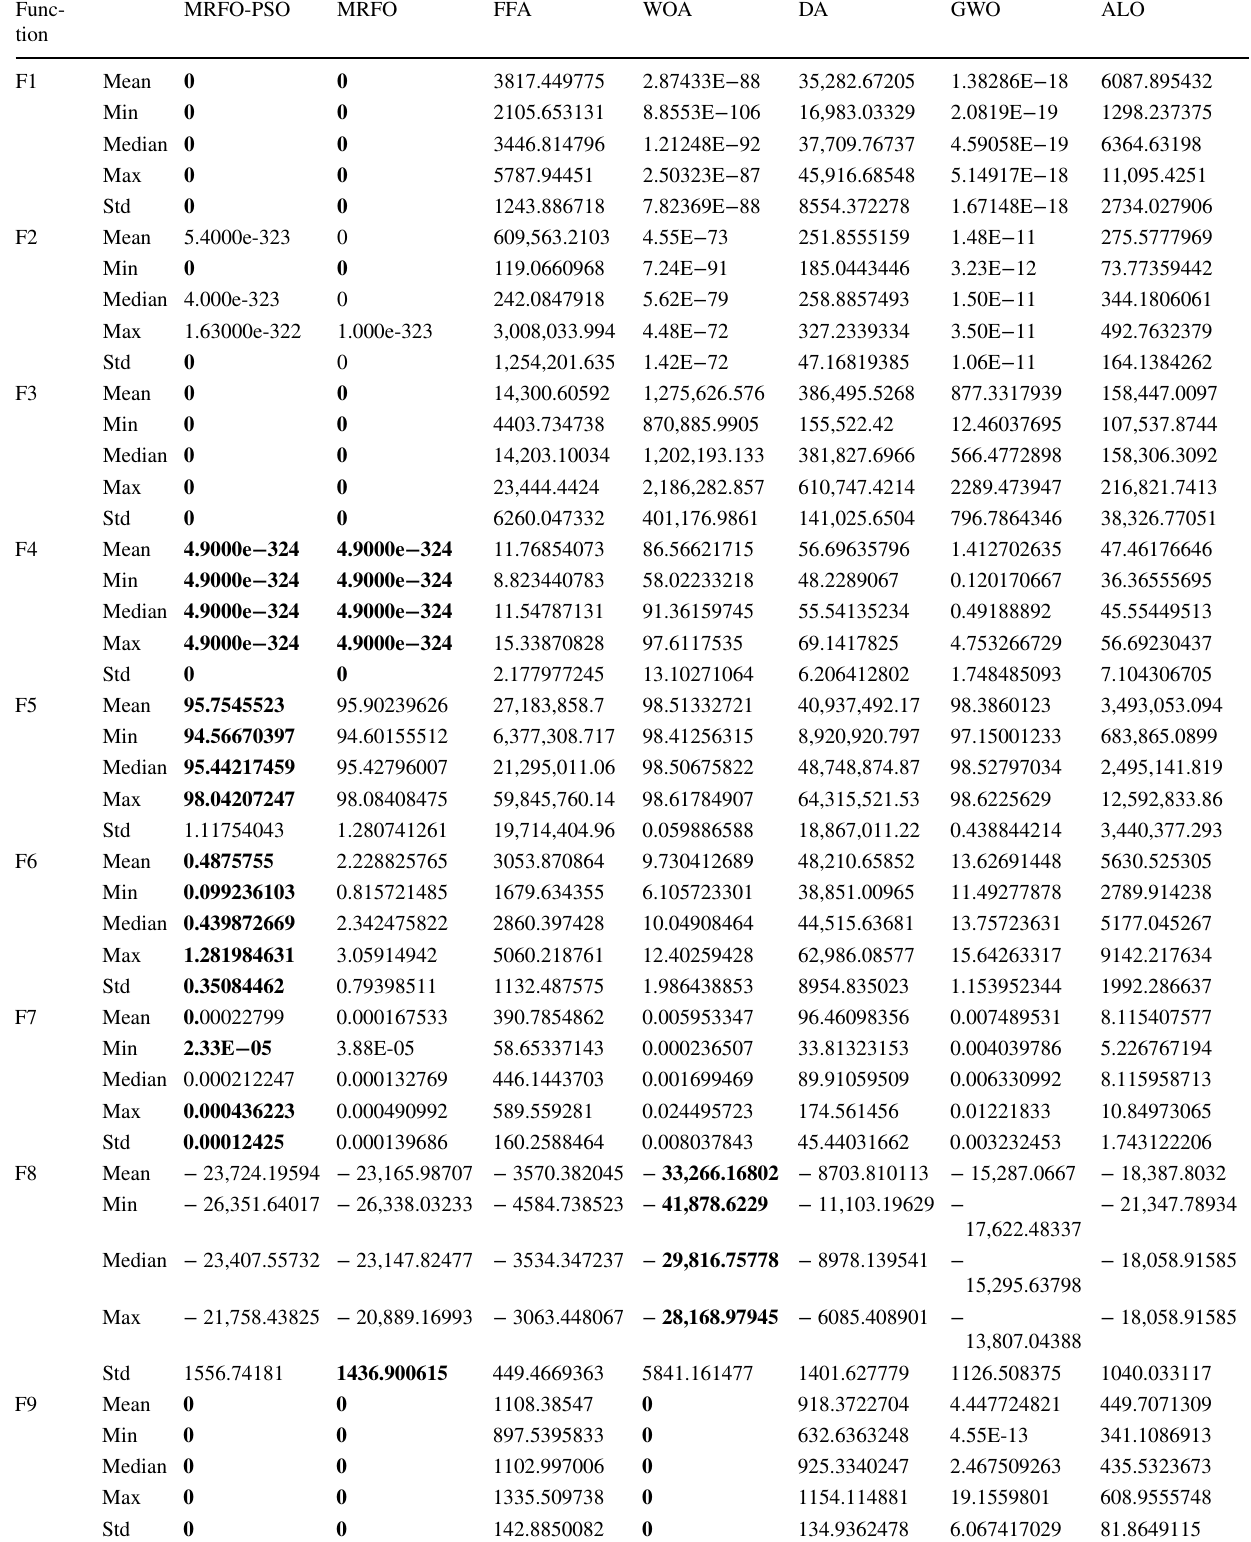
Table 4 The results obtained by MRFO-PSO and the compared algorithms Func-